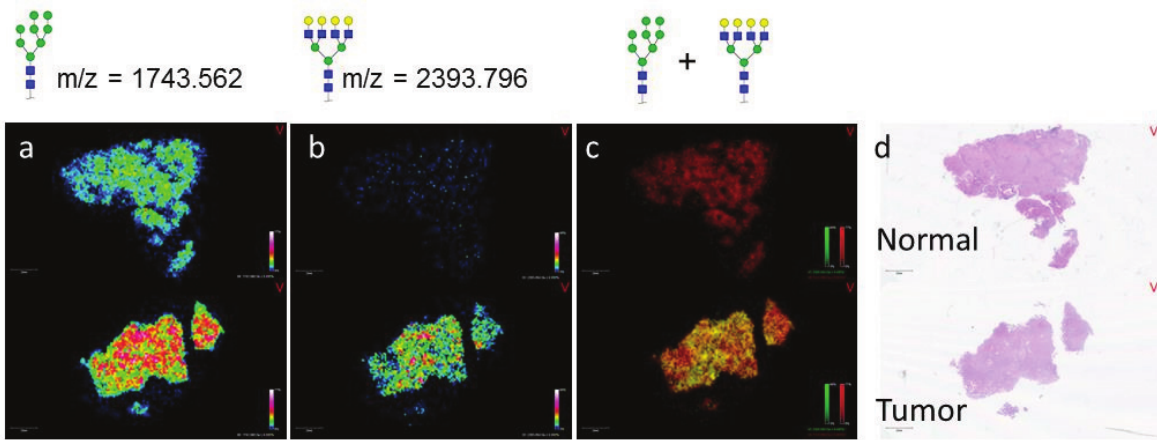
Figure 2. MALDI-IMS Reveals N -glycans that can Distinguish Tumor from Normal in Matched HCC Tissue Samples. HCC and adjacent normal tissues from the same donor (Biochain) were analyzed by MALDI-IMS after PNGaseF release of N -glycans. m / z = 1743.562 (Hex8HexNAc2 + Na) was present in both tissues ( a ); while m / z = 2393.796 (Hex7HexNAc6 + Na) was primarily in the tumor tissue only ( b ); An overlay view of these two glycan species where m / z = 1743.562 is displayed in red and m / z = 2393.796 is displayed in green confirms this finding. In the overlay, the normal tissue is primarily red but the tumor tissue is yellow in color as a result of both glycan species being present ( c ); H & E staining of both tissues ( d